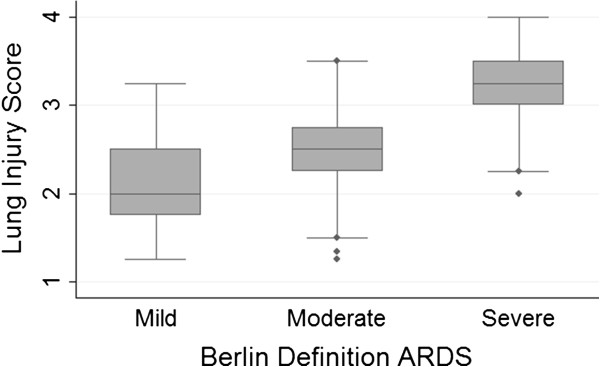
Box plot comparison of Lung Injury Score according to Berlin definition severity in 550 patients with Berlin definition acute respiratory distress syndrome (ARDS). The line in the middle of the box represents the median and the lines that form the box correspond to the 25th and 75th percentiles. The LIS increases with increase Berlin definition severity, P < 0.001 for trend.